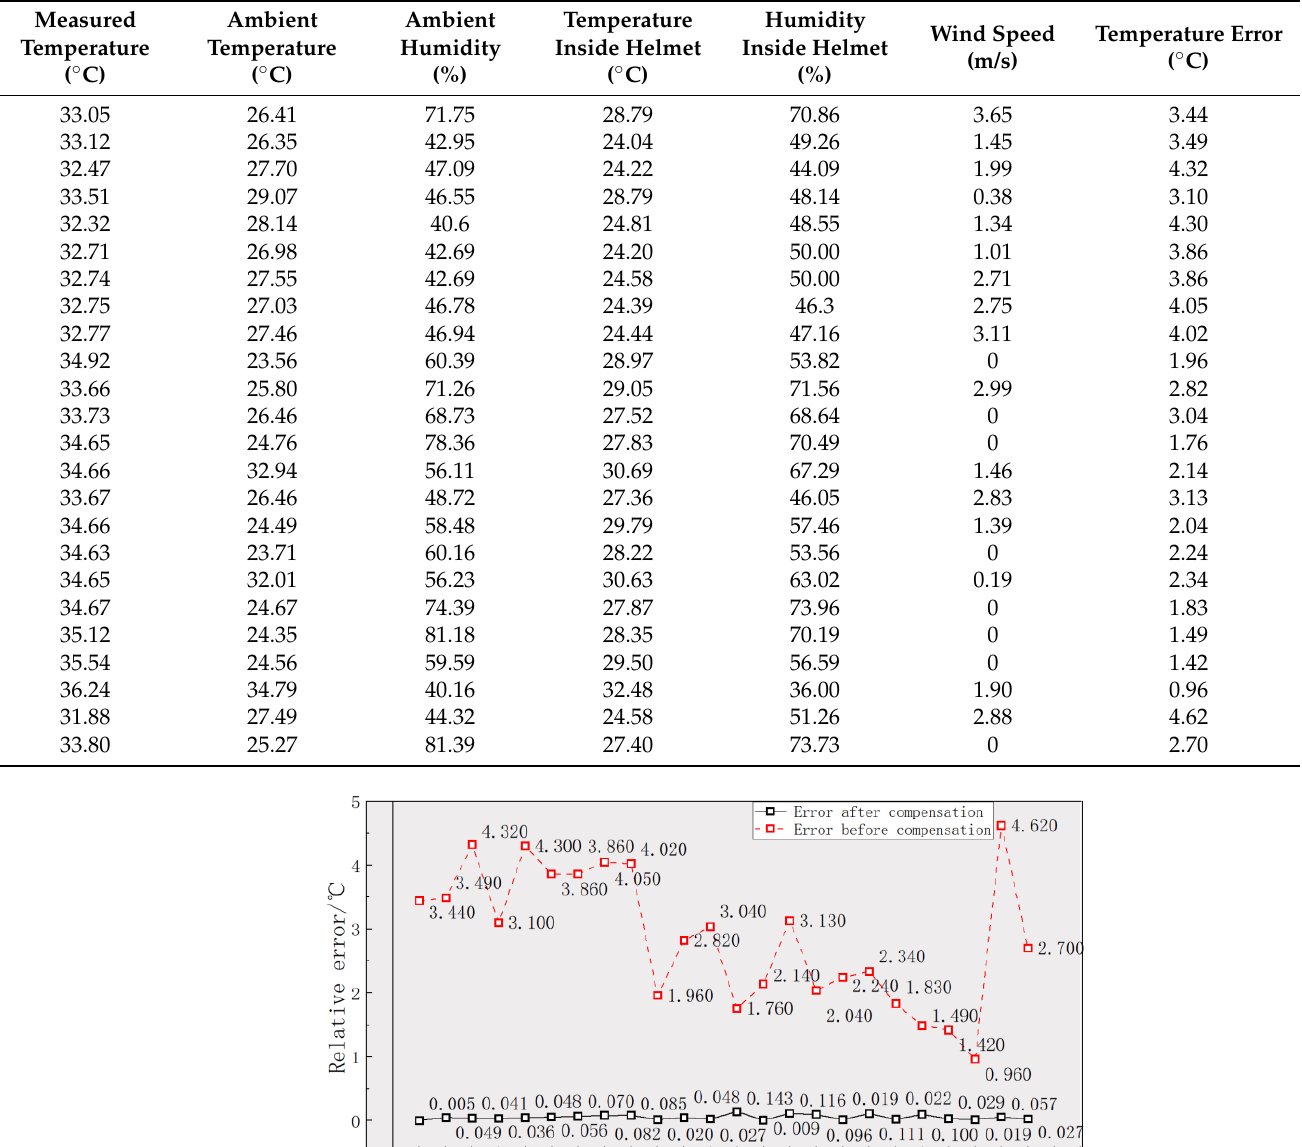
Table 3. Test data used to validate the model.